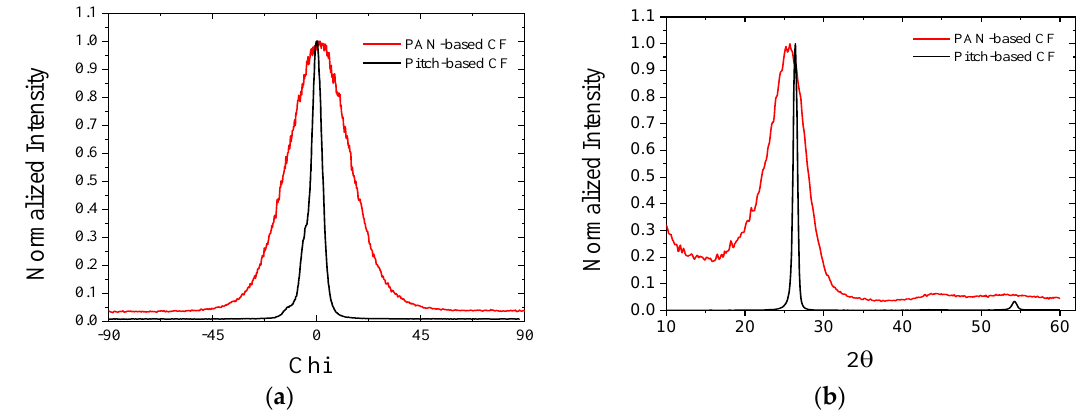
Figure 5. ( a ) Azimuthal angle distribution of intensity integrated from 20° < 2θ < 30° and ( b ) X-ray diffraction (2θ) data integrated from ± 5° (10 degrees) in the horizontal line (Φ = 0°). Figure 5b is the X-ray diffraction along the horizontal line (Φ = 0°) with ± 5° integration, and similar trends with a narrow peak of pitch-based CFs can be observed. Graphitic (002) peak around 26° is marked with the white arrow in Figure 4. FWHM of (002) peak is 0.64° for the pitch-based CF and 6.07° for PAN-based CF, respectively. Similarly, the (100) peak, located at 42–45°, is also integrated along the vertical line (Φ = 90°) with ± 5°.